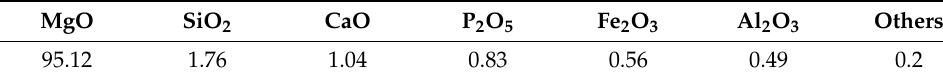
Table 1. Chemical composition of dead-burned magnesia (wt%).